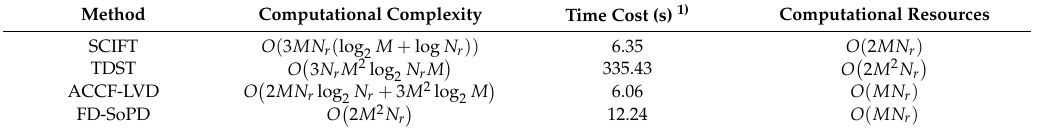
Table 1. The computational burden comparisons of different algorithms.